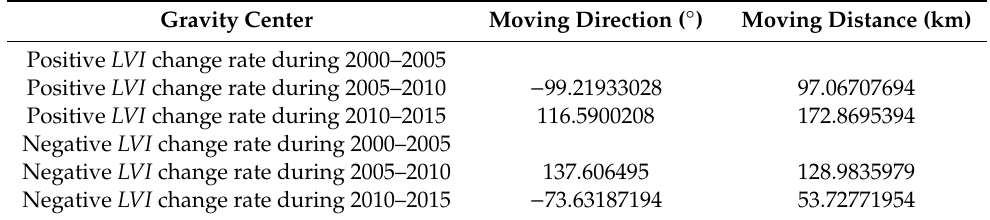
Table 2. Moving distances and directions of gravity